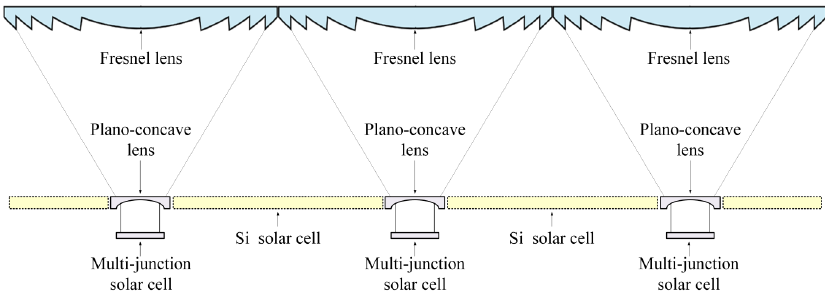
Figure 1. Design of the proposed concentrator photovoltaic (CPV) system. Si,